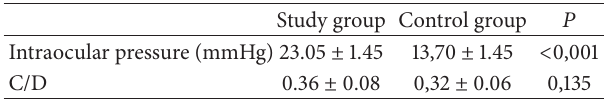
Table 2: Comparison of intraocular pressure and vertical C/D.